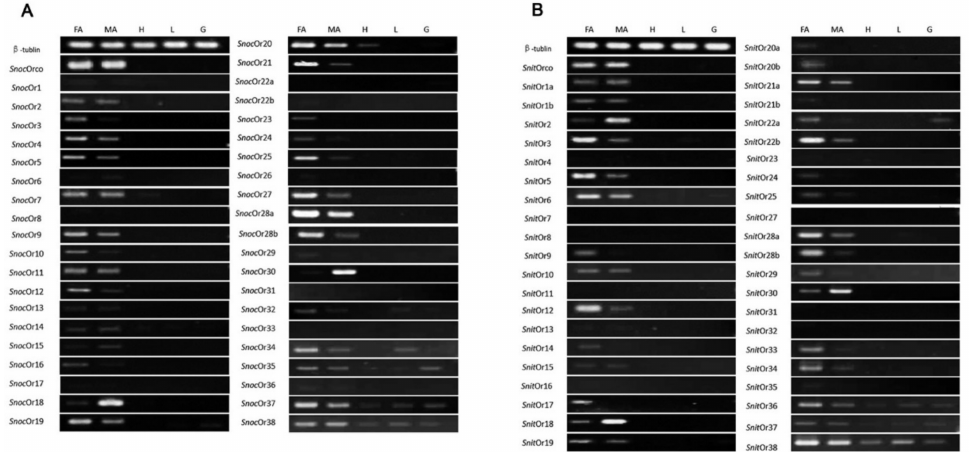
Figure 5. Tissue-specific expression of candidate OR genes were evaluated by RT-PCR. ( A ) S. noctilio , ( B ) S. nitobei . FA: female antennae; MA: male antennae; H: head; L: legs; G: genitals. β -Tubulin used as a reference gene for each cDNA